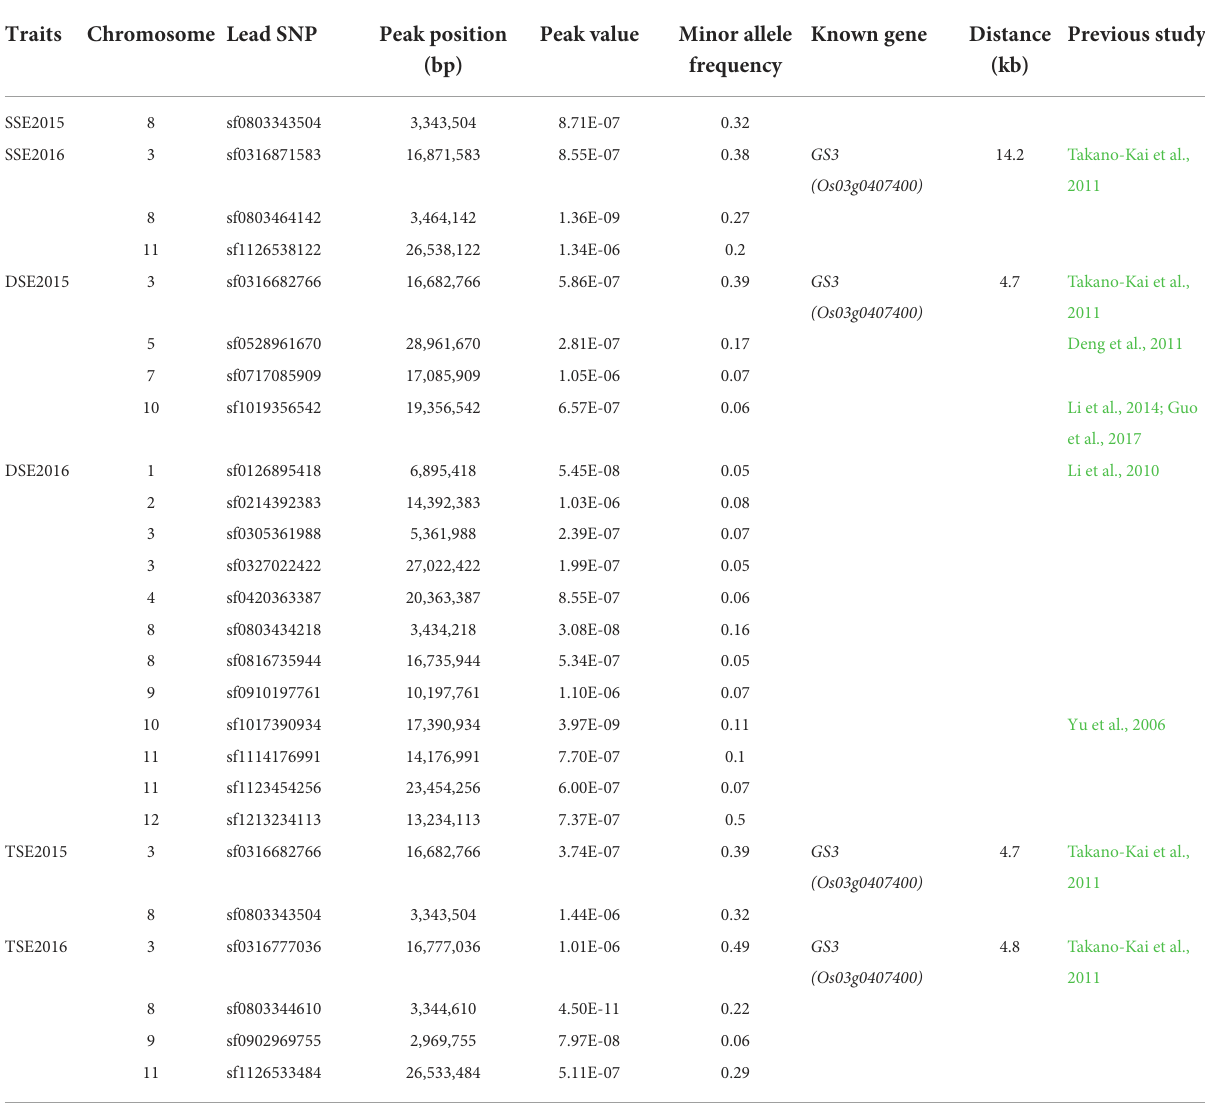
TABLE 4 Summary of GWAS loci for stigma exsertion rate in Collection 2.